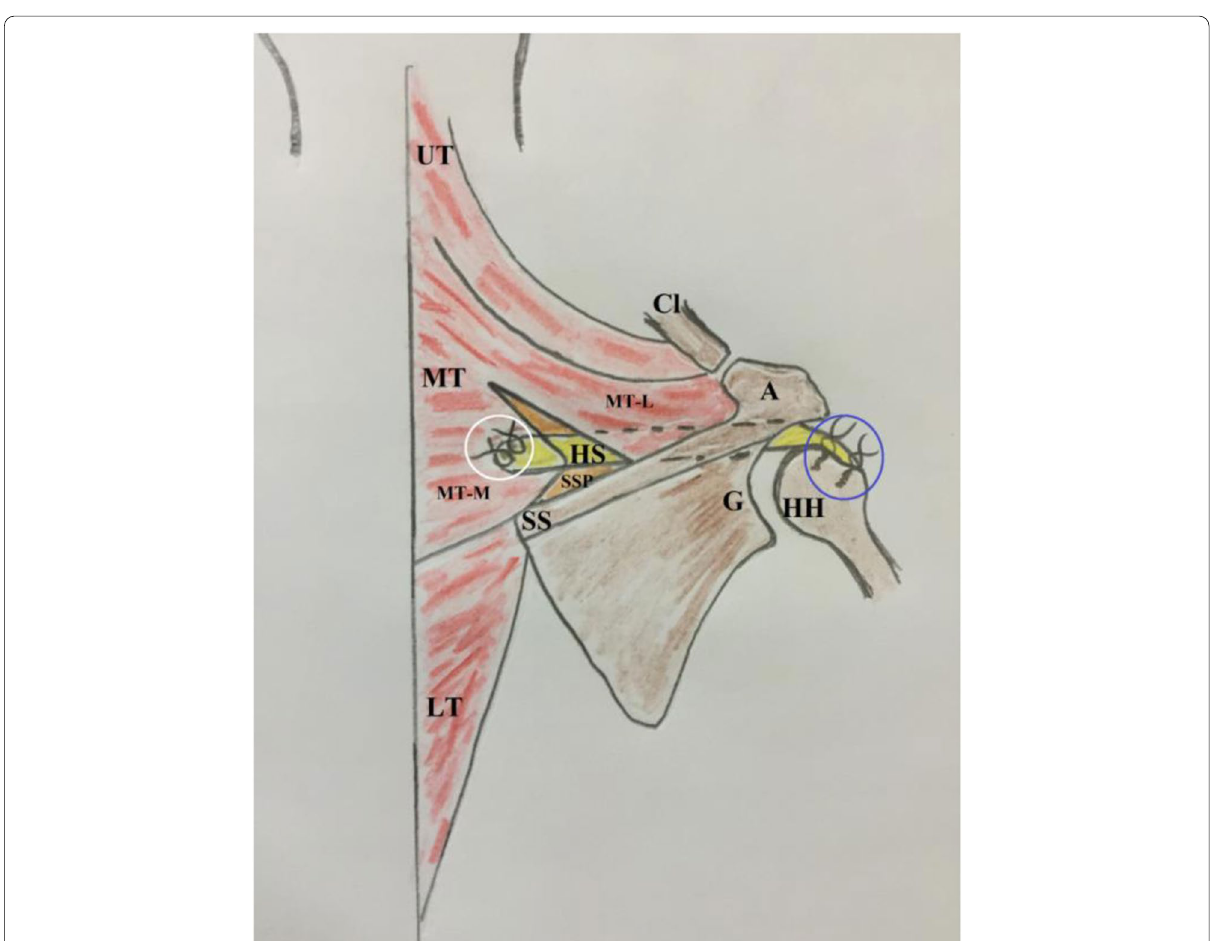
Fig. 1 demonstrates technical principle of currently reported technique of middle trapezius tendon transfer for reproduction of supraspinatus function in the right shoulder. In this technique, the middle trapezius tendon is partially (medially) released (i.e. from medial half of the scapular spine), augmented/lengthened by an interposition fashioned sheet of hamstring tendon autograft using non‑absorbable sutures (marked in white circle), and transferred in a sub‑trapezius/sub‑acromial corridor to the humeral head where it is re‑attached in double‑row suture configuration (marked in blue circle) to the footprint of supraspinatus tendon for management of rotator cuff irreparability/re‑tear; A, acromion; C, coracoid; Cl, clavicle (lateral end); G, glenoid, HH, humeral head; HS, hamstring sheet; LT, lower trapezius; MT, middle trapezius; MT‑L, middle trapezius (lateral insertion); MT‑M, middle trapezius (medial insertion); SS, scapular spine; SSP, supraspinatus muscle